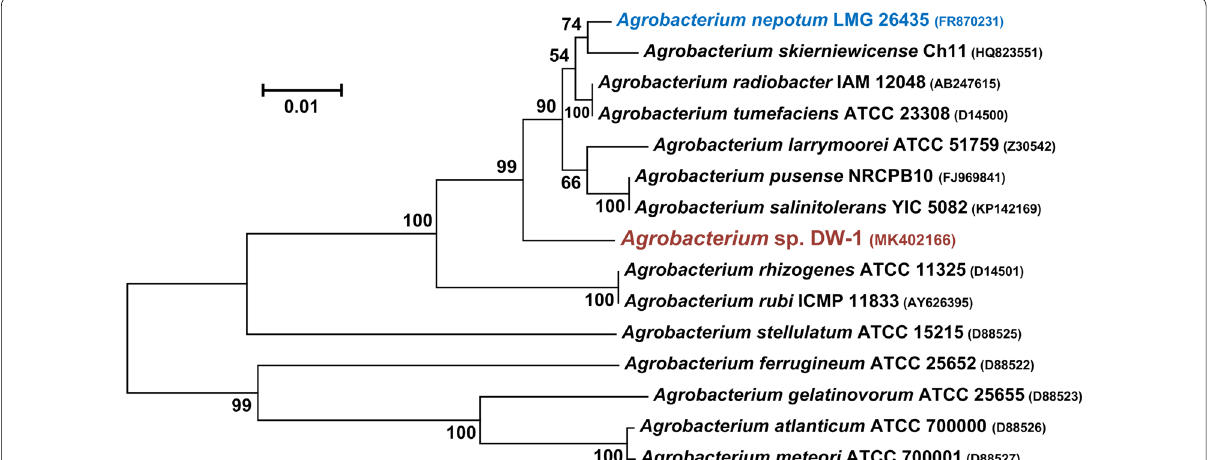
Fig. 2 Neighbour-joining tree expression the relationships among Agrobacterium sp. DW-1 and the relatives, based on 16S rRNA sequences. Horizontal branch lengths are proportional to the estimated number of nucleotide substitutions and bootstrap probabilities (as percentages) are determined from 1000 resamplings